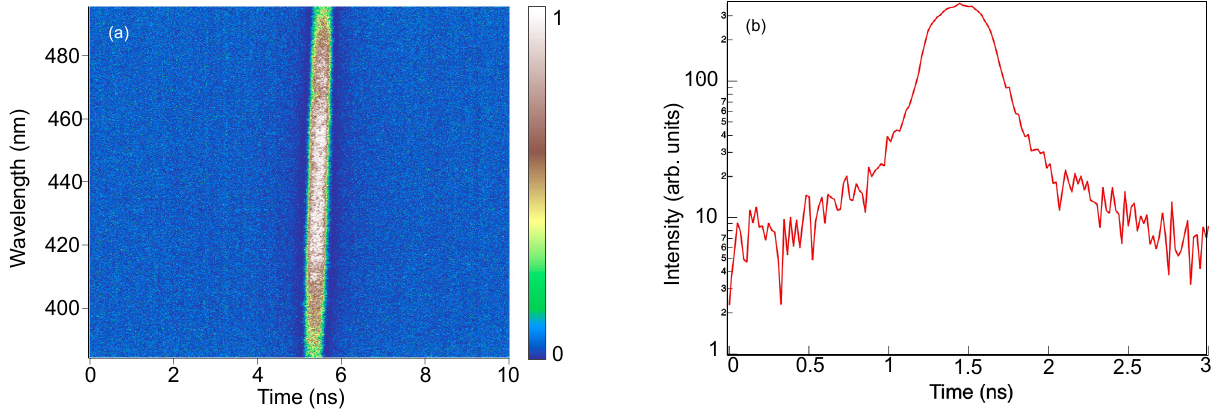
Figure 10. ( a ) Streak camera image showing the time-resolved PL spectrum of TiO 2 with 1000 nm thickness; ( b ) temporal profile of the time-resolved PL spectrum. The PL emission has a fast decay time of about 2 ns.